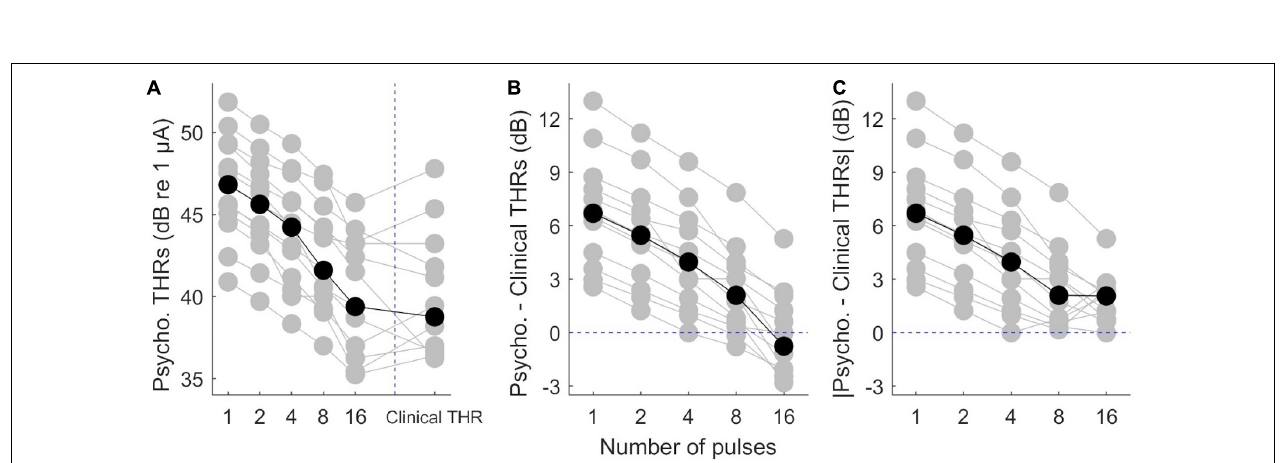
FIGURE 3 | Results of psychophysical THRs. (A) Psychophysical THRs as a function of number of pulses. Clinical THRs of all subjects are plotted in the most right side of panel (A) . (B) The difference between psychophysical THRs and clinical THRs as a function of number of pulses. (C) The absolute values of the data in panel (B) . The gray circles show results of individual subjects while the black circles show the corresponding median values over all